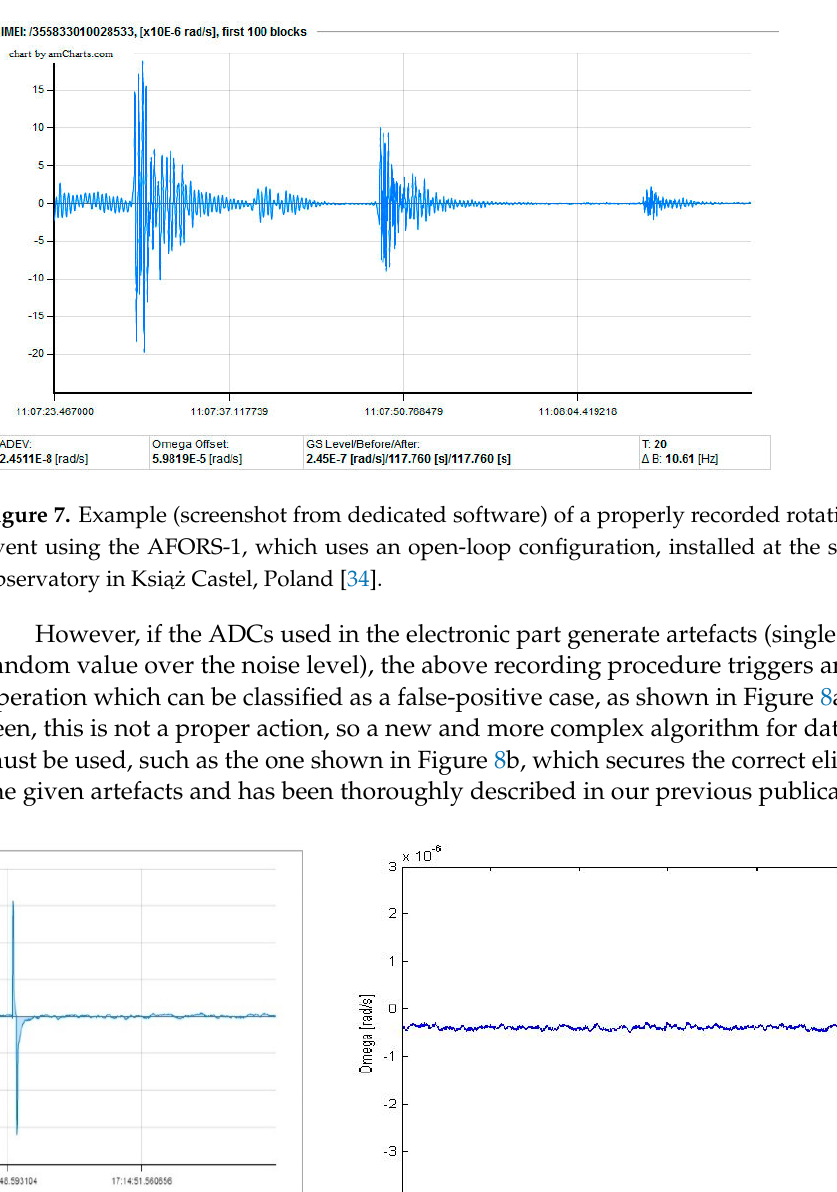
Figure 6. Comparison of the spectral accuracy of the different investigated resampling methods applied to a signal from Figure 5b.